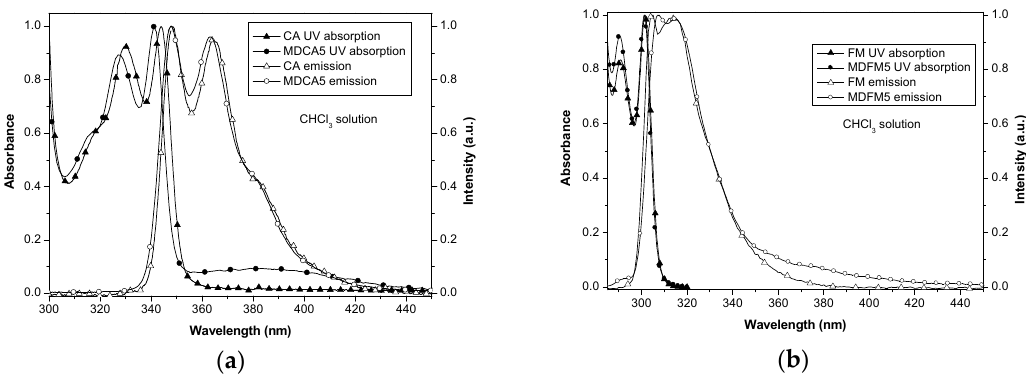
Figure 6. UV-Vis absorption and fluorescence emission spectra: ( a ) CA and MDCA5 in CHCl 3 , λ exc = 290 nm, and ( b ) FM and MDFM5 in CHCl 3 , exc = 270 nm. Spectra are normalized to absorption and emission maximum, respectively.